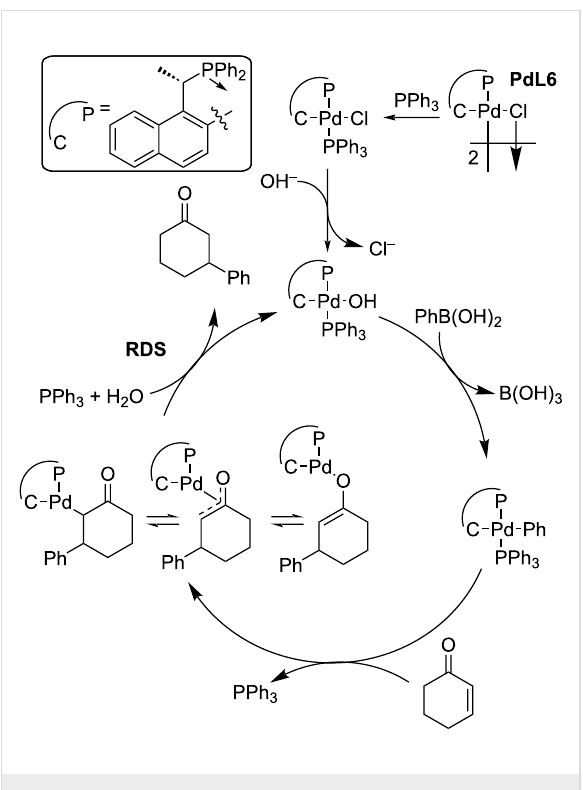
Scheme 8: Plausible catalytic cycle of the addition of phenylboronic acid to 2-cyclohexenone catalysed by palladacycle PdL6